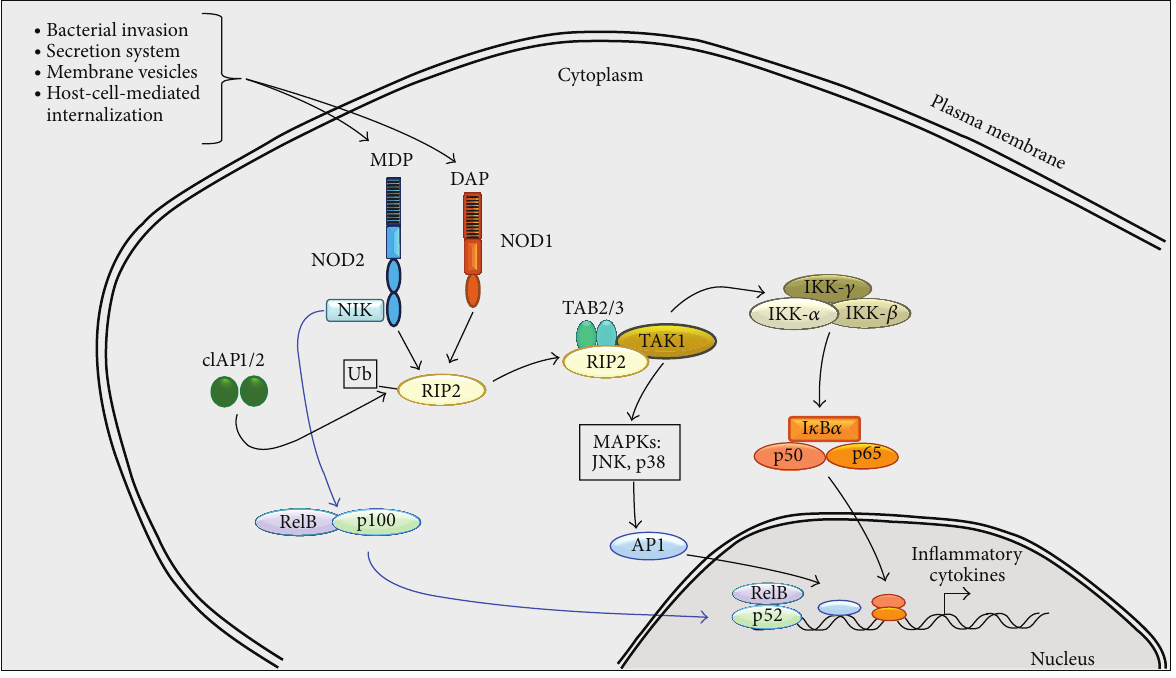
Figure 2: NOD1 and NOD2 signaling. Bacteria or their components reach the cytosol by several mechanisms. The interaction between NOD2 and NIK ( blue arrows ) activates the noncanonical NF- 𝜅 B pathway (p100/p52-dependent). While binding of PGN to LRR domain of NLRs leadstorecruitmentofRIP-2throughCARD-CARDinteraction( blackarrows ).UbiquitinationofRIP-2favors,ontheonehand,theactivation of the MAPKs p38/JNK, and on the other hand activates IKK complex, which induces the activation of NF- 𝜅